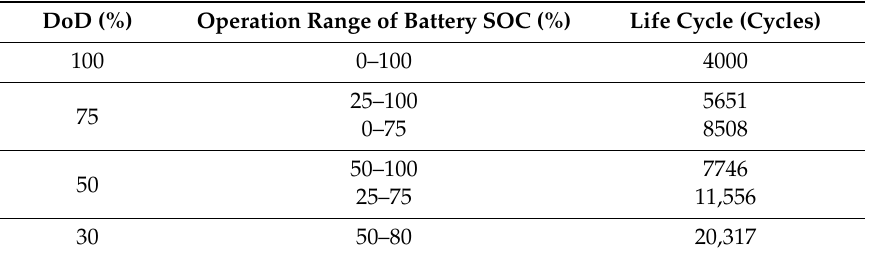
Table 3. Life cycle characteristic of a battery depending on DOD and the operation range of the state of charge (SOC).